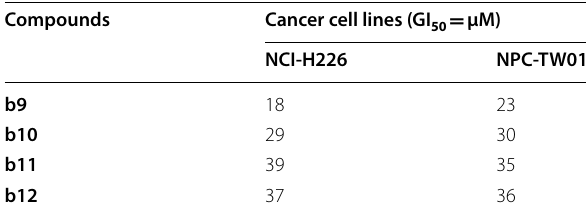
Table 19 Antiproliferative results of active compounds (b9–b12) Compounds